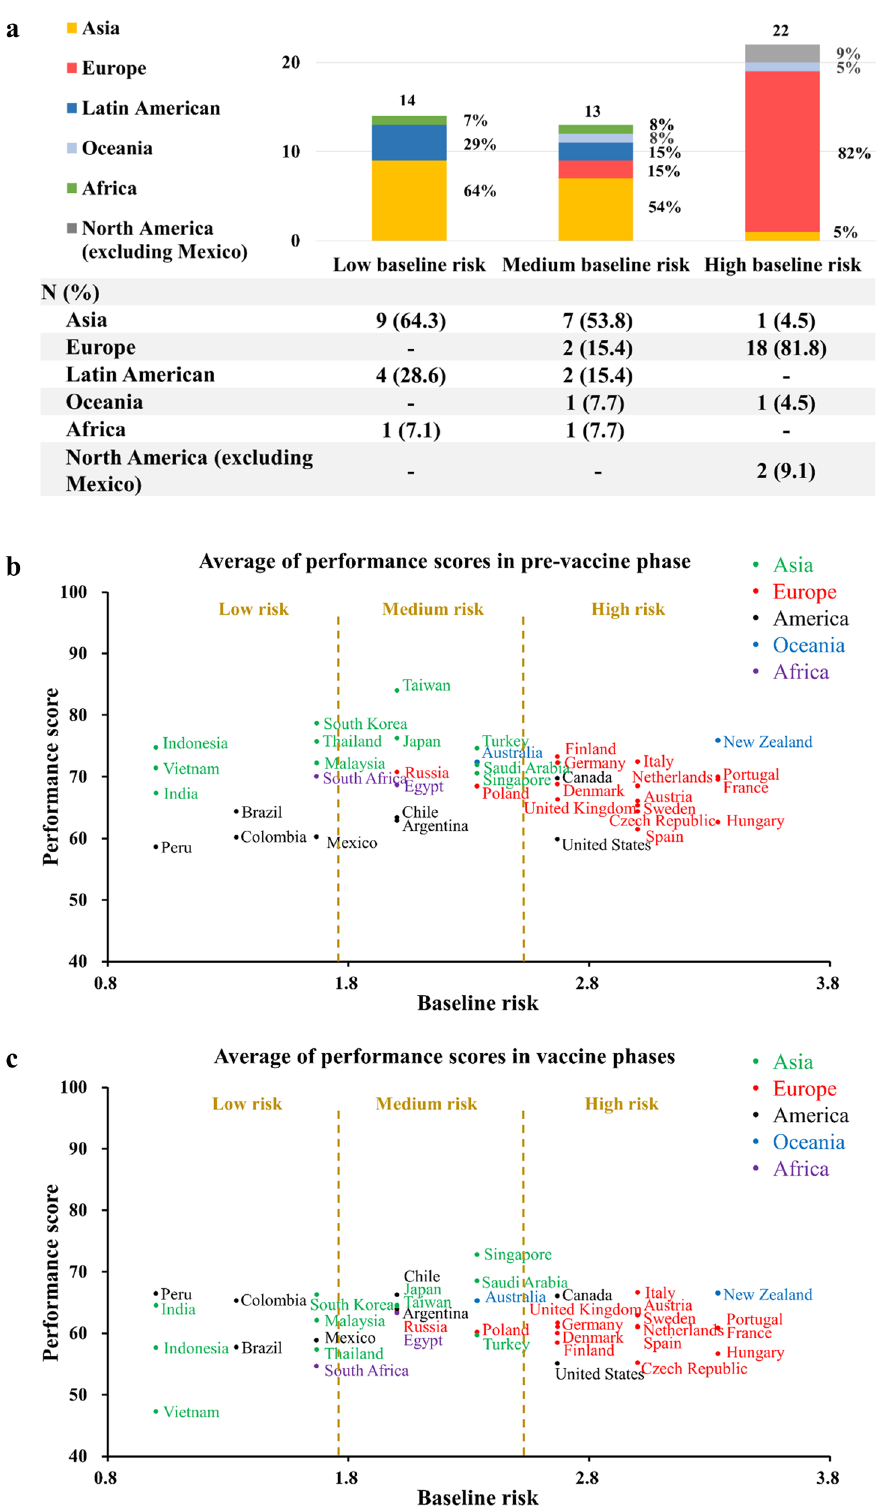
Figure 3. Distribution of baseline risk levels of countries and territories in each geographic region ( a ), and for containment scores (with Google Trends data) in pre-vaccine phase ( b ) and in vaccine phases ( c ). Note that most low- and medium-baseline-risk countries and territories are located in Asia, Latin America, and Africa, while high-baseline-risk areas are located mainly in Europe and North America (excluding Mexico). Note: Hong Kong is excluded due to insufficient data for calculating baseline